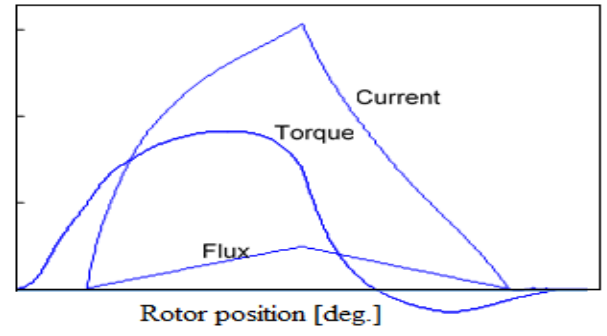
Fig. 2. Illustrations of phase current, torque and